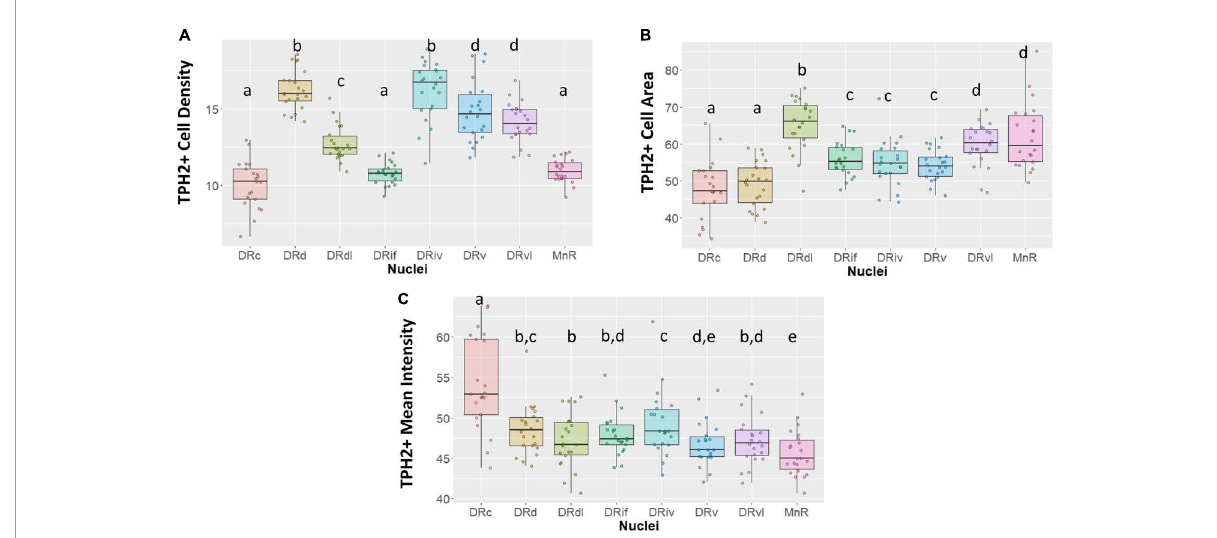
FIGURE2 Tryptophan hydroxylase 2 (TPH2) cell measurements across subnuclei within the greater raphe nuclei. Data are expressed as box plots with boxes indicating the 1st–3rd quartile range and the median expressed as the horizontal bold line. Nuclei that share letters (e.g., “a”) are not significantly different from each other, different letters indicate significant differences between subnuclei at p < 0.05. Bonferroni corrections were made when making multiple comparisons across all different subnuclei included. In instances denoted with multiple letters (e.g., “a, b”) these groups are not significantly different from any groups that are also denoted with the same letter. (A) Number of TPH2+ cells in each subnuclei region. (B) Cell area in pixels of TPH2+ cells. (C) Mean intensity of TPH2 signal per image. DRd, dorsal nucleus of the dorsal raphe; DRdl, dorsolateral nucleus of the dorsal raphe; DRv, ventral nucleus of the dorsal raphe; DRvl, ventrolateral nucleus of the dorsal raphe; DRiv, fourth nerve nucleus of the dorsal raphe; DRif, interfascicular nucleus of the dorsal raphe subnucleus; MnR, median raphe